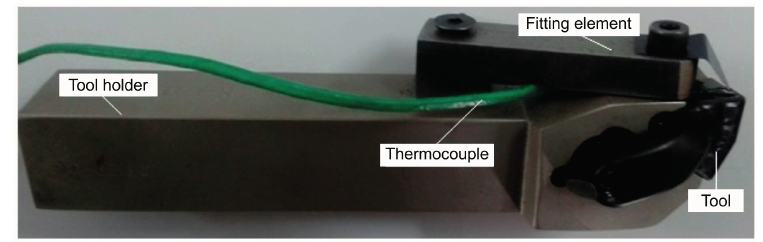
Figure 8. Mounting of thermocouple onto the tool holder.